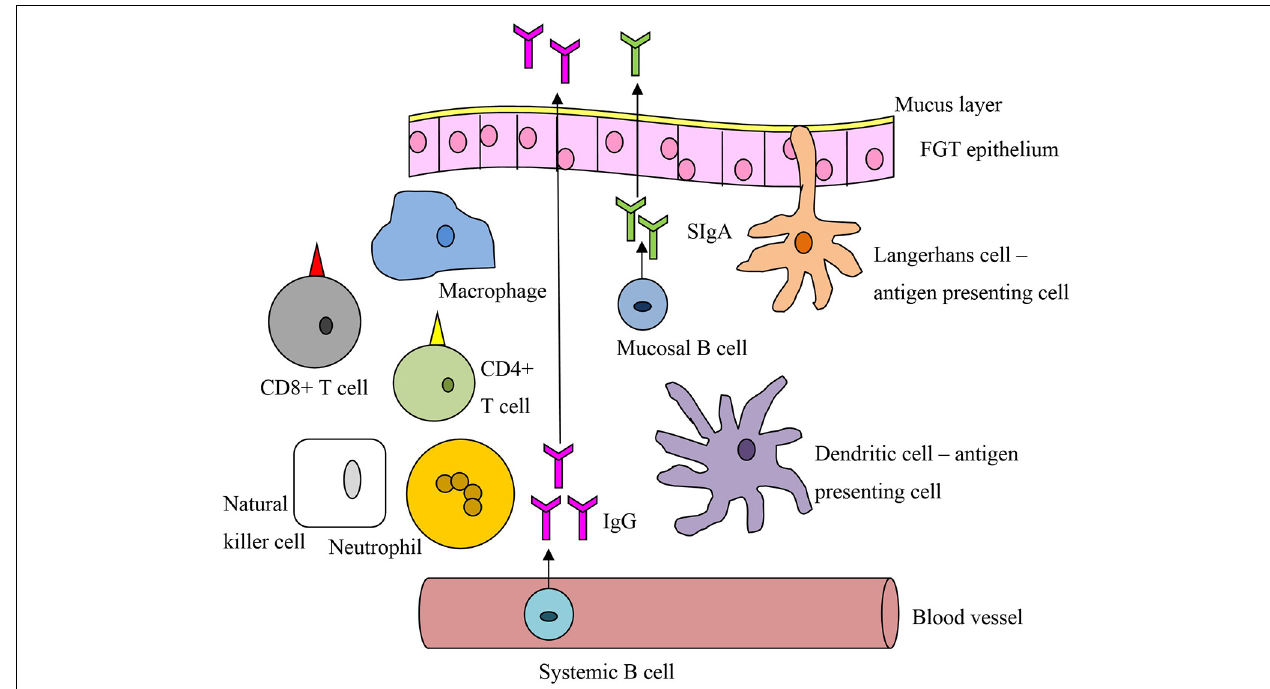
FIGURE 3 | A general schematic of vaccine-related immune cells active at the mucosal interface of the female genital tract.